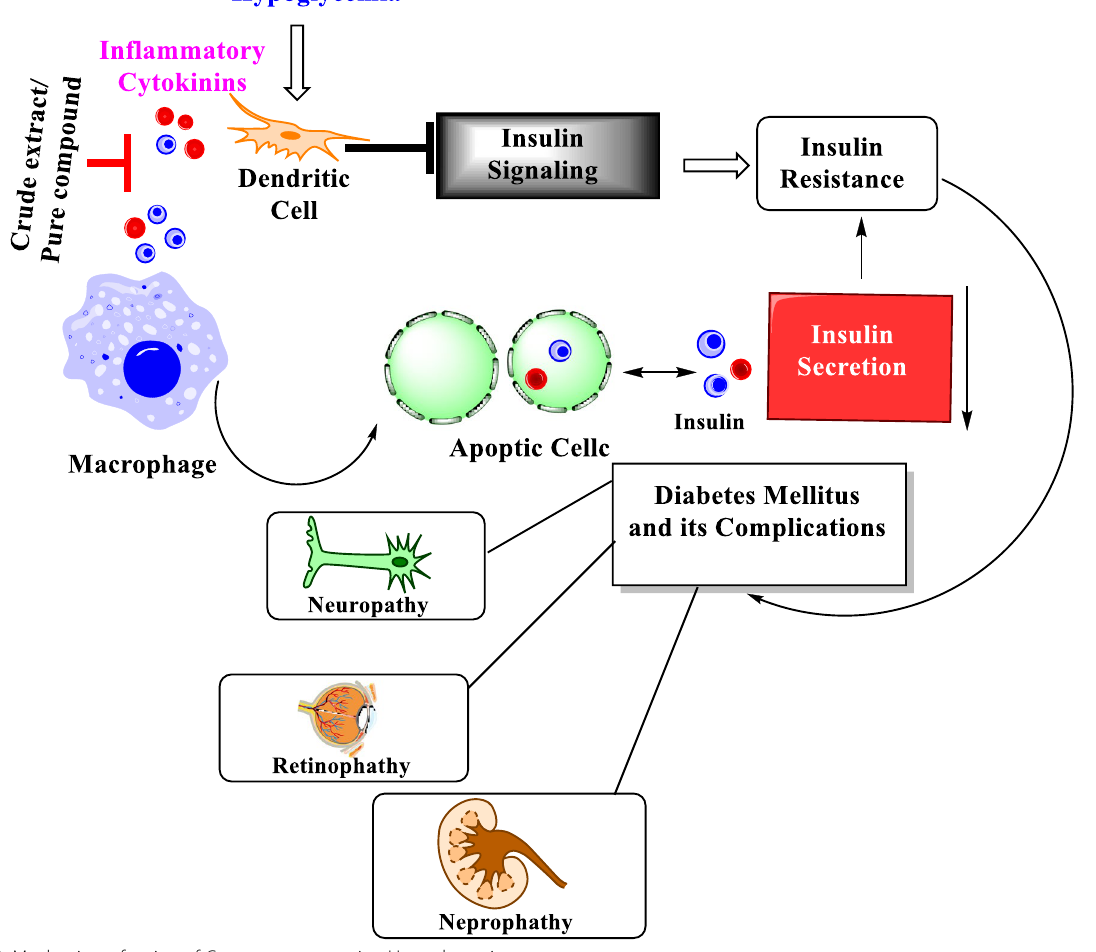
Fig. 5 Mechanism of action of C. procera parts against